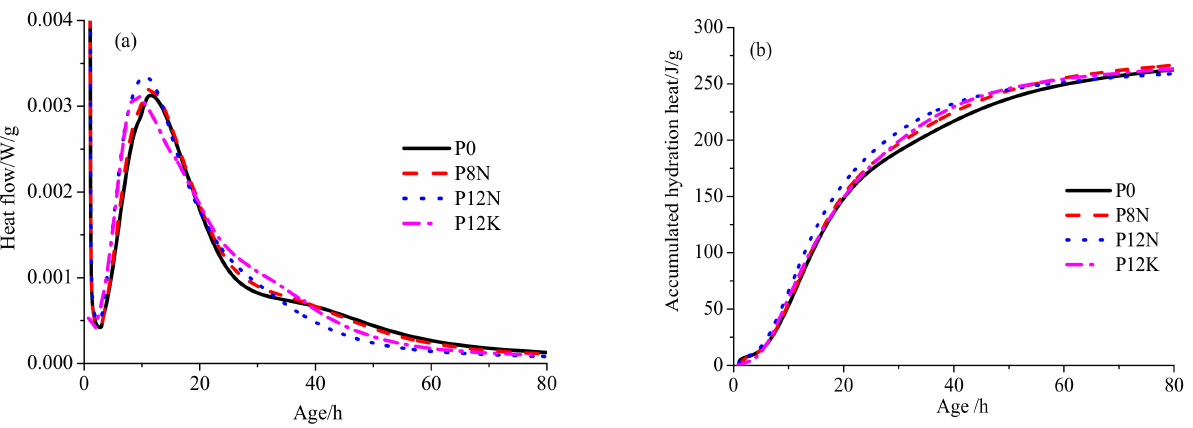
Figure 8. The heat flow ( a ) and accumulated hydration ( b ) heat of OPC pastes with different alkali sulfates